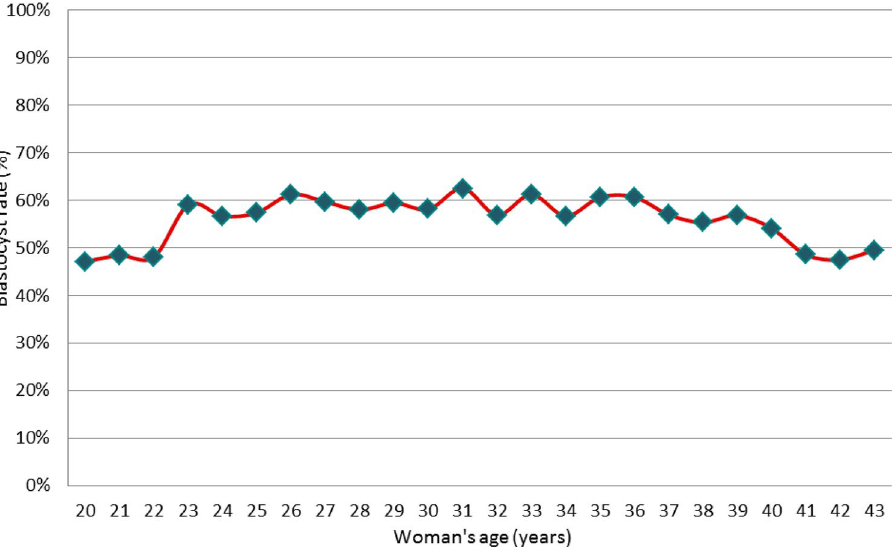
Figure 1. Blastocyst rate by the woman’s age. The blastocyst rate is the ratio between the number of blastocysts obtained at D5 or D6 and the number of normally fertilized zygotes at D1.